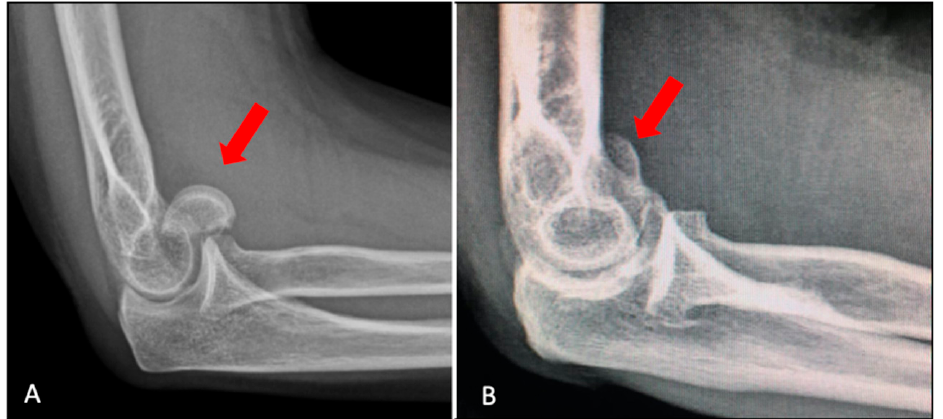
Figure 4. ( A ) Lateral X-ray showing the fracture fragment (red arrow) dislocated anterior to the distal humerus. ( B ) In cases of Bryan–Morrey Type II fracture, the injury looks like a loose body (red arrow). A radiographic fat pad sign along with mechanism and physical examination consis-